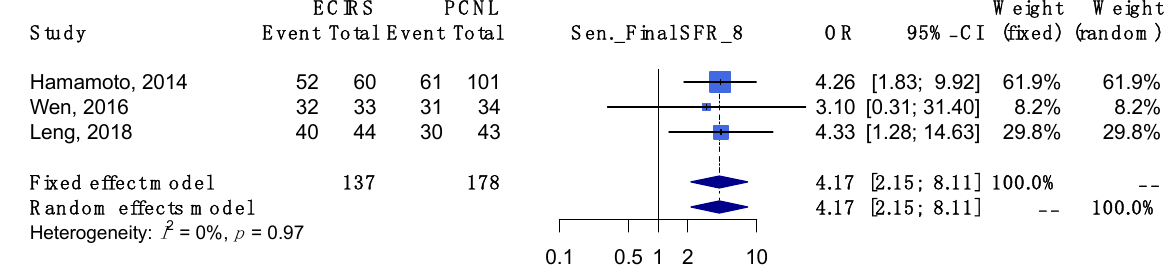
Figure A29. Sensitivity analysis of outcome regarding final stone free rate. ([17,19,22]).